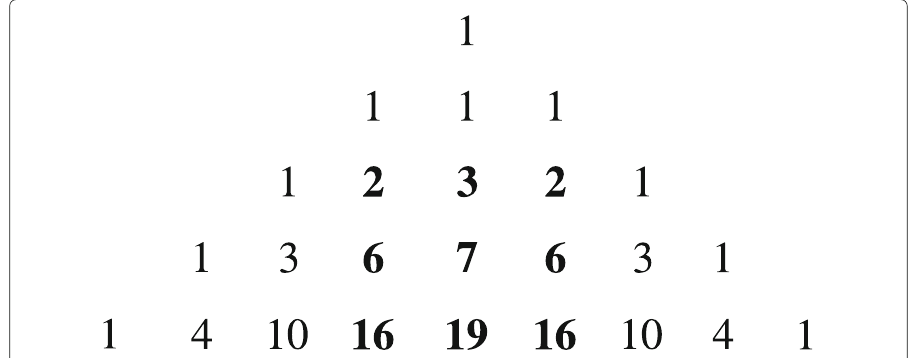
Fig. 4 First 5 rows of the trinomial triangle. The sum of emphasized trinomial coefficient values in each line m equals the number of nodes in the labeling networks S ( m